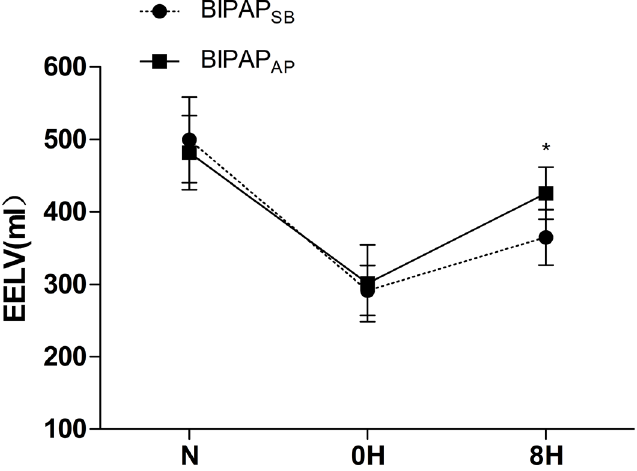
Fig 3. Time course of the EELV. Time course of the end- expiratory lung volume (EELV) in experimental groups (n = 6 per group). BIPAP SB = biphasic positive airway pressure with SB; BIPAP AP = biphasic positive airway pressure with abdominal muscles paralysis; SB = spontaneous breathing; * P < 0.05, vs. other